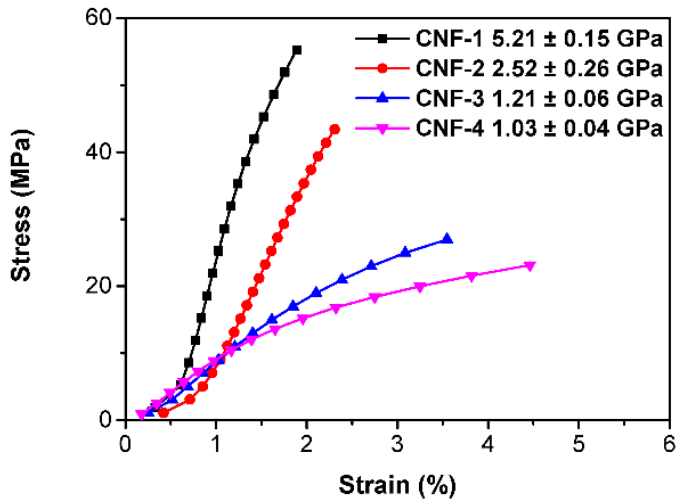
Figure 13. Dry membrane tensile strength DMA.